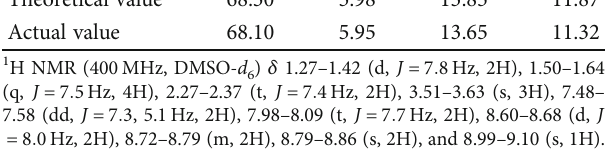
Table 2: Elemental composition of 2,2 ′ :6 ′ ,2 ″ -terpyridine-4 ′ -carboxylic acid.